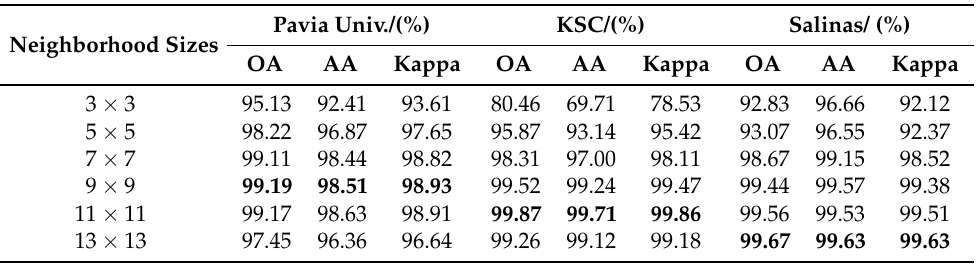
Table 7. Test accuracies with different neighborhood sizes of Pavia Center, Pavia University, and KSC datasets.